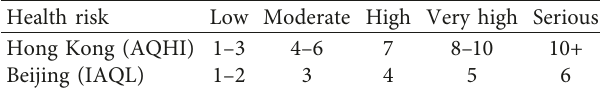
Table 1: Air quality classifications and health risk.